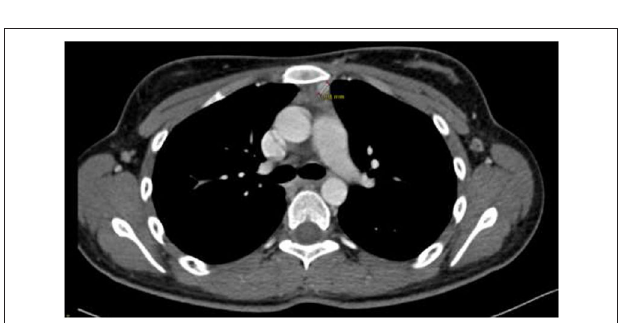
FIGURE 2 | CT scan of the chest showing solid nodularity approximately 9mm in diameter in the anterior mediastinum.